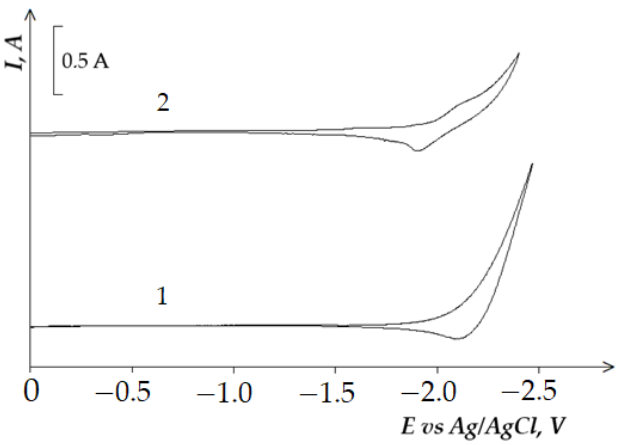
Figure 2. Cyclic voltammograms of the Dy 3+ ions electroreduction on the tungsten electrode in the equimolar KCl-NaCl melt at 973 K. Concentration of DyCl 3 : curve 1–0 mol/cm 3 , curve 2–3.0 × 10 − 4 mol/cm 3 . A square of a cathode is 0.42 cm 2 . Polarization rate is 0.2